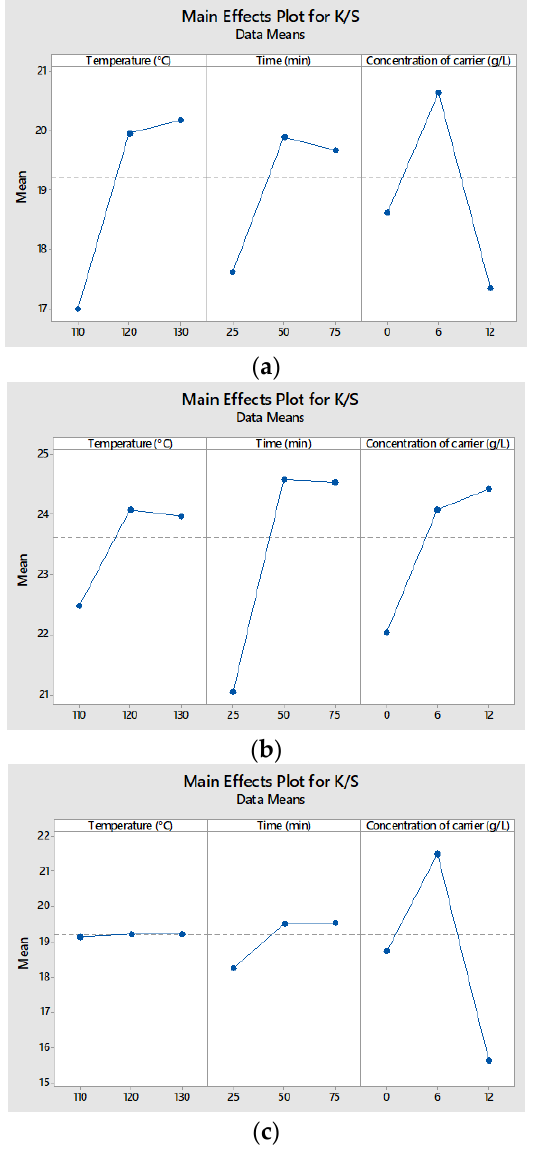
Figure 11. Mains e ff ects plots for color yield (K / S) of bicomponent filaments dyed with: ( a ) Dye #H; Figure 11. Mains effects plots for color yield (K/S) of bicomponent filaments dyed with: ( a ) Dye #H; ( b ) Dye #M; ( c ) Dye ( b ) Dye #M; ( c ) Dye #L.